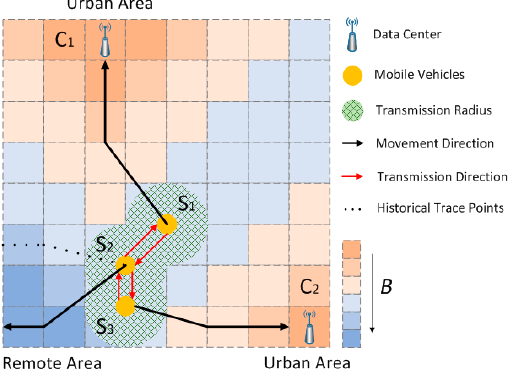
Figure 4. Schematic diagram used to summarize the LCODC scheme.